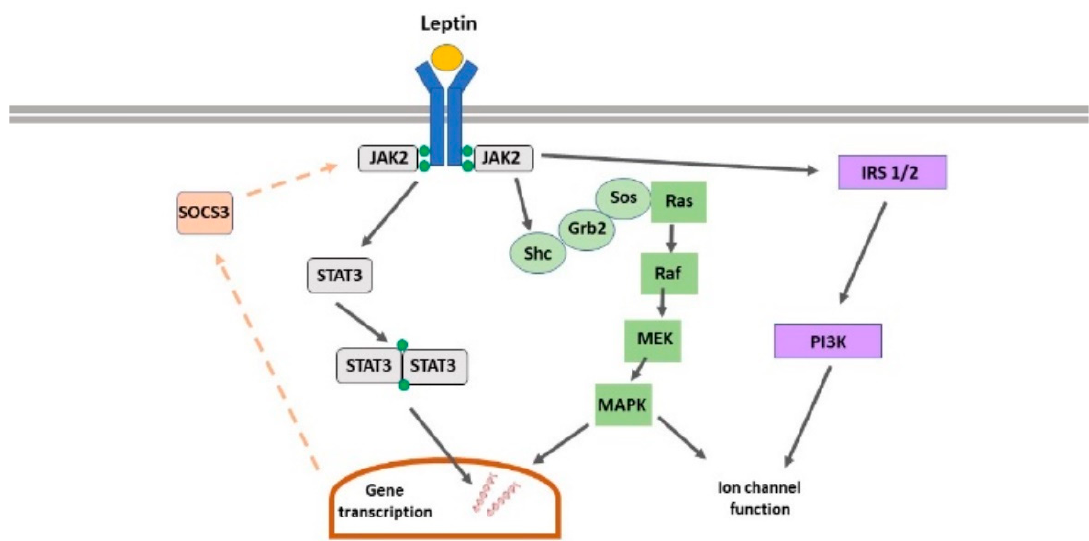
Figure 1. Leptin receptor-driven signalling in neurons. The key signalling pathways activated following leptin binding to leptin receptors (LepRs) and subsequent activation of janus tyrosine kinase (JAK)2 are shown including signal transducers and activators of transcription (STAT3), Ras-Raf-MEK-MAPK and phosphoinositide 3-kinase (PI3K), which ultimately lead to gene transcriptional changes or altered ion channel function. LepR signalling is terminated following the production of suppressor of cytokine signalling (SOCS)3.